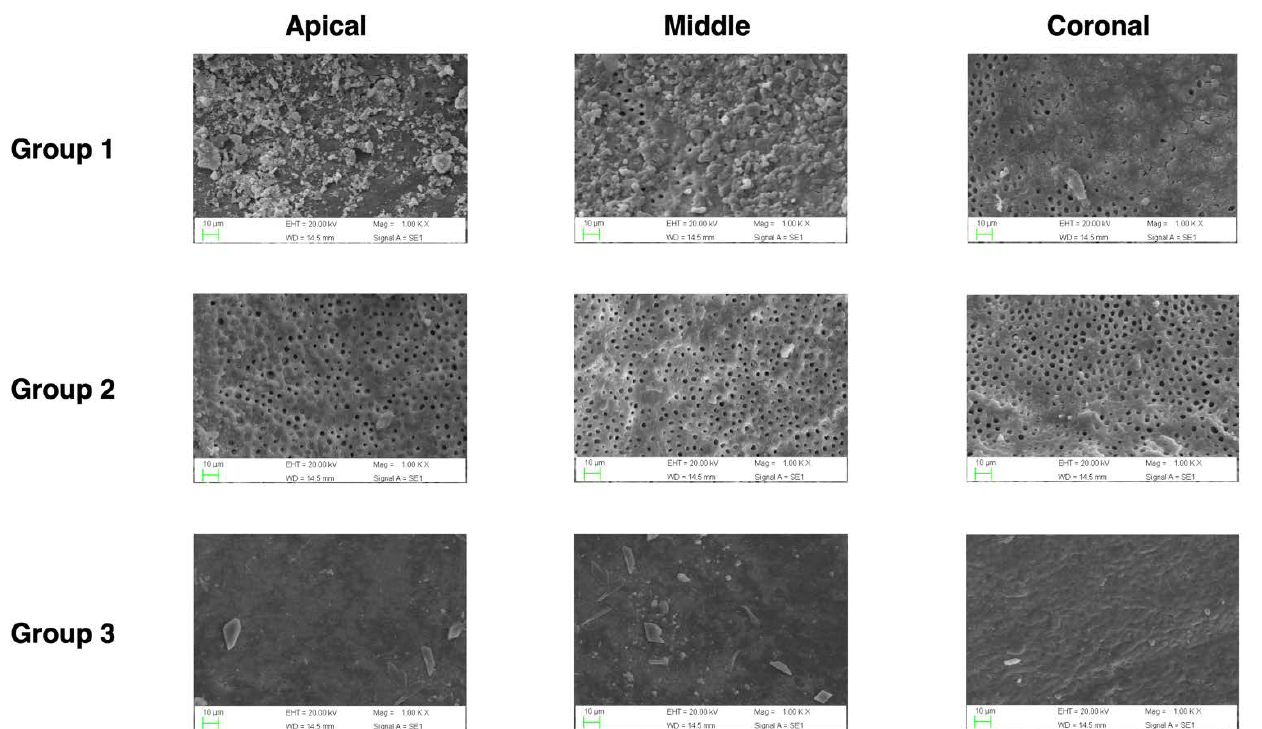
Figure 1. Representative samples of scanning electron microscope images of the coronal, middle and apical thirds after irrigation of the control group, traditional irrigation group and 3D Cleaning group (1000× magnification).